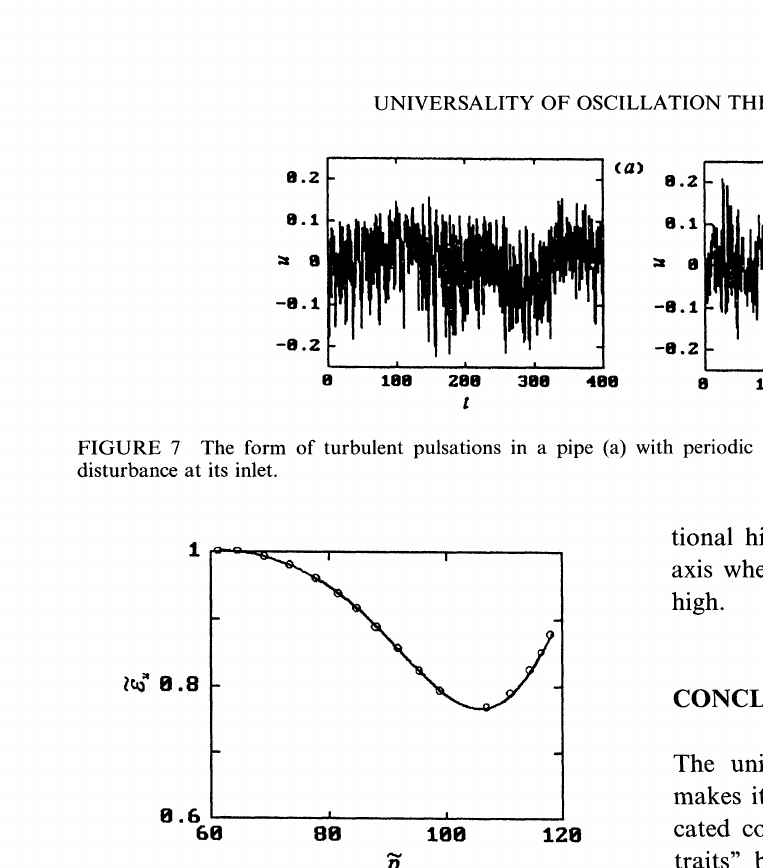
FIGURE 8 The experimental dependence of e, on the rela- tive amplitude of acoustic pressure /?a measured in decibels for St 2.35, x/D